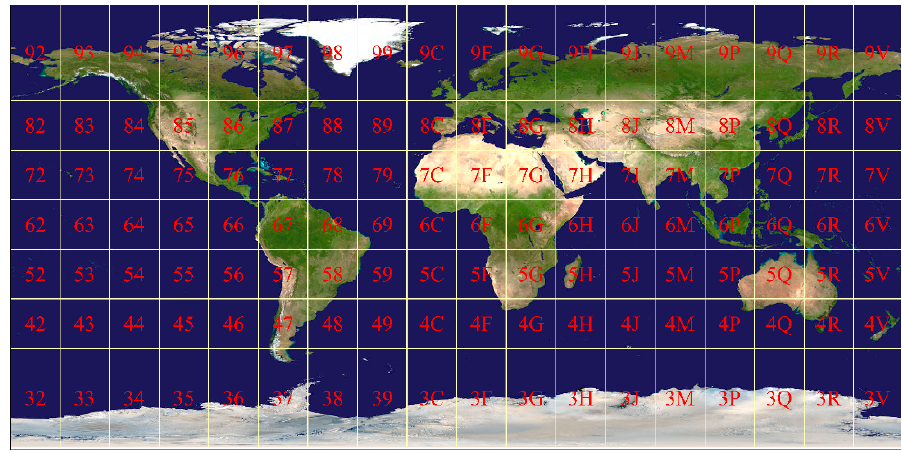
Figure 2. Level 0 Grid with Open Location Code (OLC) on spatial segmentation indexing (SSI) Model. Table 1. Precision of the valid code lengths on different level.